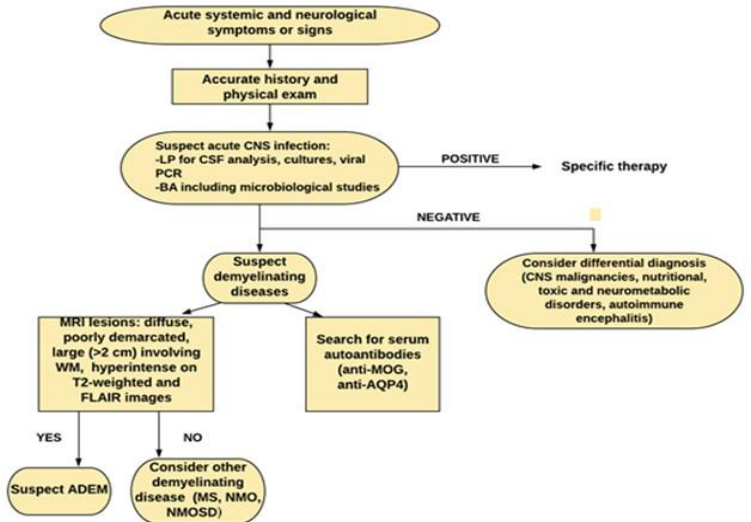
Figure 2. Diagnostic work-up in pediatric acute disseminated encephalomyelitis (ADEM). LP: lumbar puncture, BA: blood analysis, WM: white matter.